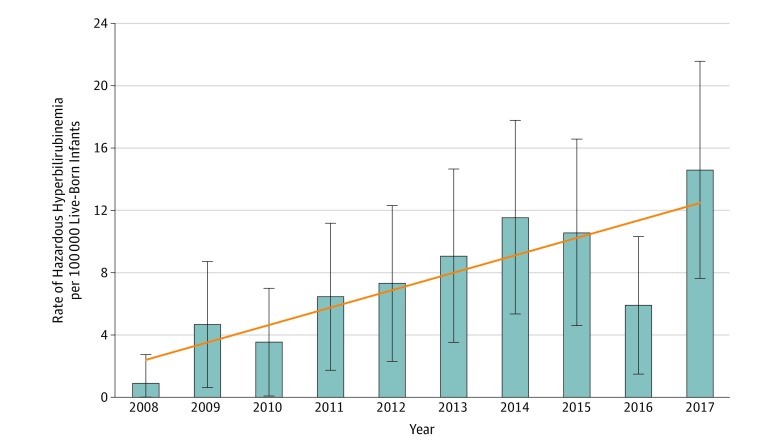
Annual Rate of Newborns (≥35 Weeks’ Gestational Age) With Hazardous Serum Bilirubin Levels (≥30 mg/dL) in SwedenError bars indicate 95% CIs; diagonal line, linear trend over time (the SI unit for the bilirubin levels is ≥510 μmol/L).